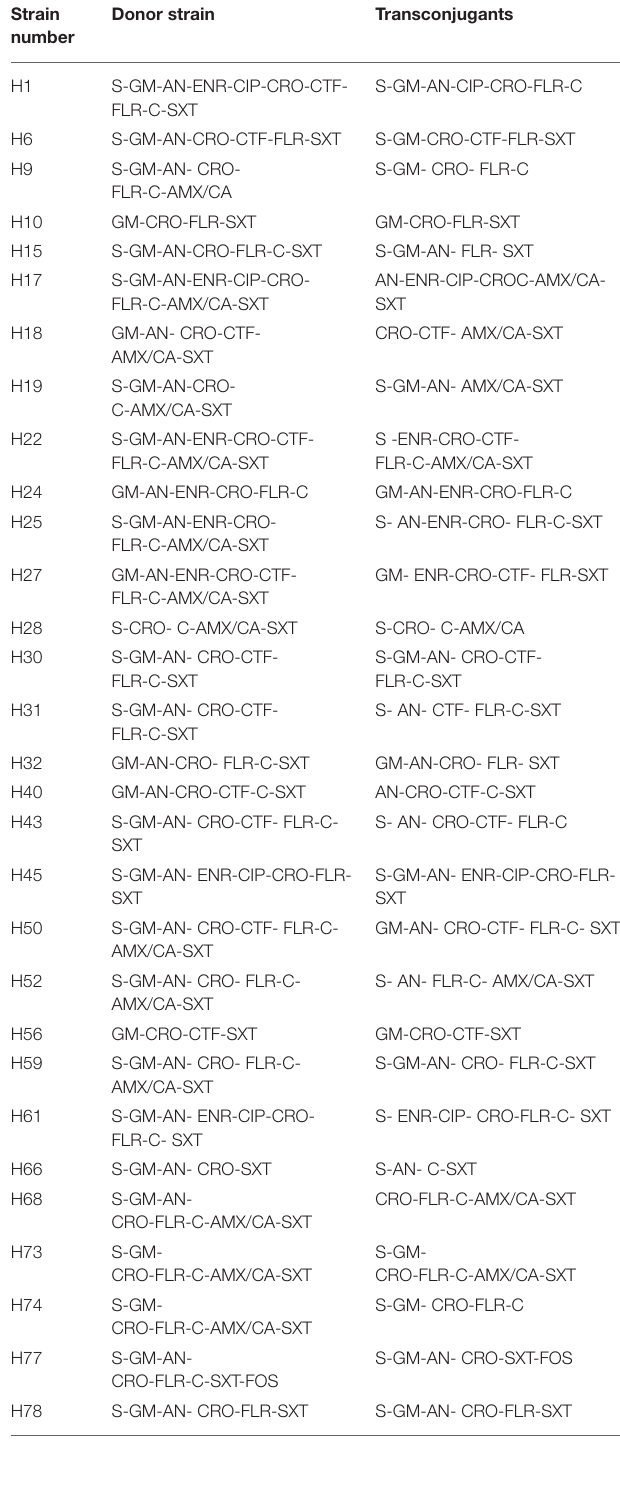
TABLE 4 | The number of mixed serotypes in pathogenic E. coli isolates. Serotype